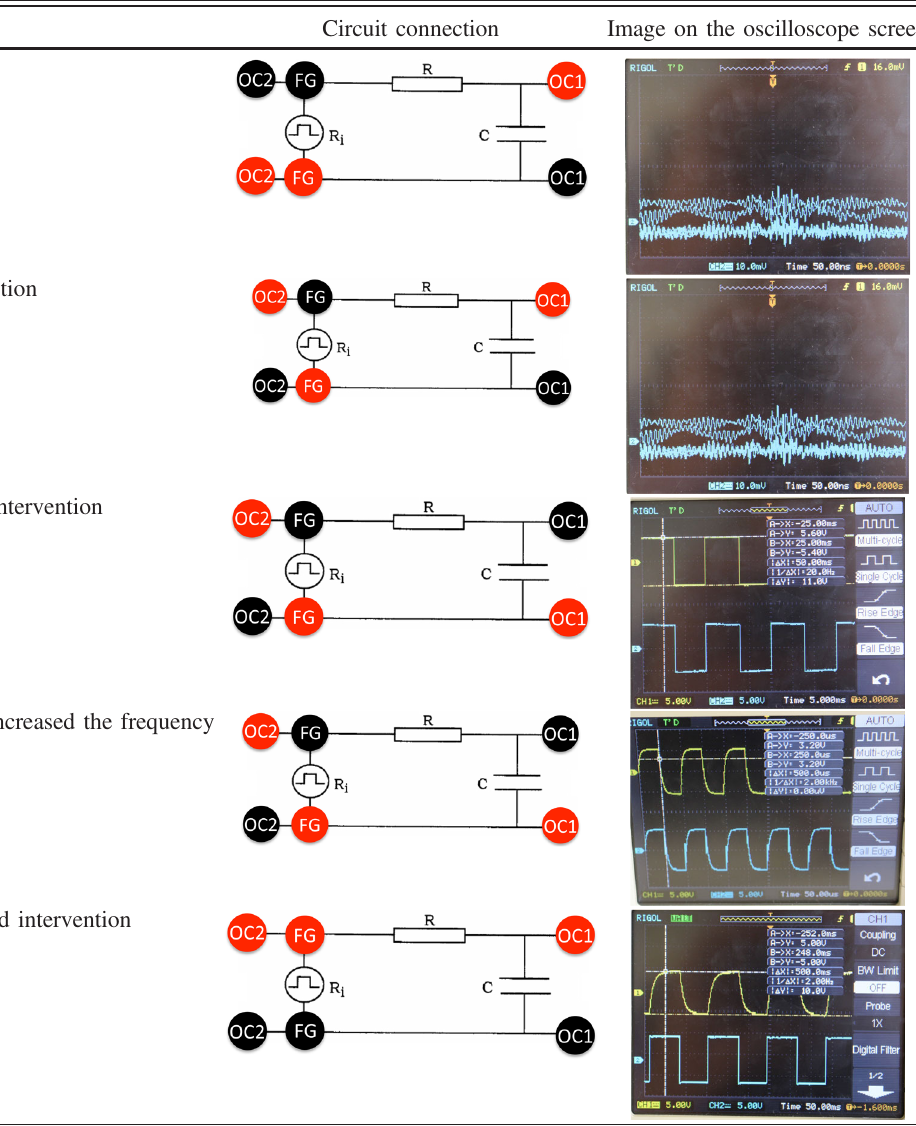
TABLE I. Summary of the illustrative vignette showing the sequence of connections and reconnections of the circuit that the students carried out and the oscilloscope images obtained at each stage. The signal from the function generator and the capacitor are shown in blue and yellow,